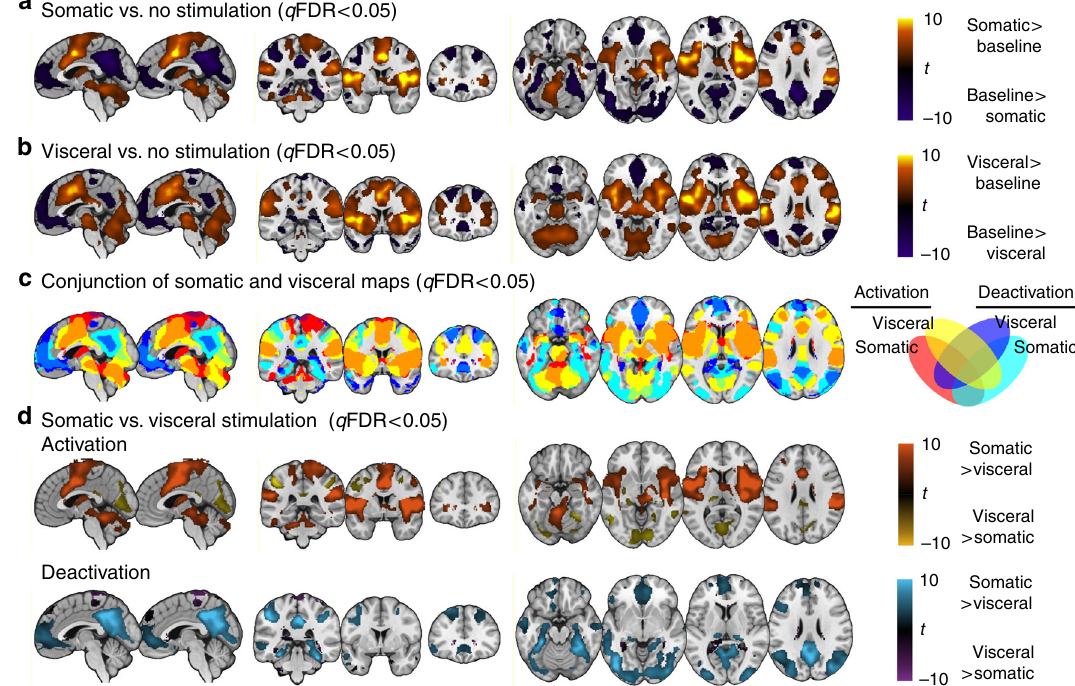
Fig. 4 Common and distinct fMRI activation for somatic and visceral pain, assessed using univariate voxel-based GLMs. Parametric group-level maps of responses across participants and studies, controlling for interstudy differences. a The contrast of somatic stimulation versus baseline. Warm colors correspond to increased levels of activation and cool color deactivation ( N = 76). b The contrast of visceral stimulation versus baseline ( N = 89). c The conjunction of activation and deactivation maps for somatic and visceral stimulation ( N = 165; the intersection of signi fi cant somatic and visceral results). d Contrasts of somatic ( N = 76) and visceral pain ( N = 89). In the top panel, effects are masked with the map of somatic pain > baseline for orange areas and visceral pain > baseline for yellow areas. Thus, the resulting maps show stimulus-related increases that are stronger for somatic (orange) or visceral (yellow). In these bottom panels, the difference map is masked with somatic pain < baseline for cyan areas and visceral pain < baseline for purple areas. Thus, the resulting maps show areas where stimulus-related deactivation occurs and is stronger in somatic pain (cyan), and deactivation occurs and is stronger in visceral pain